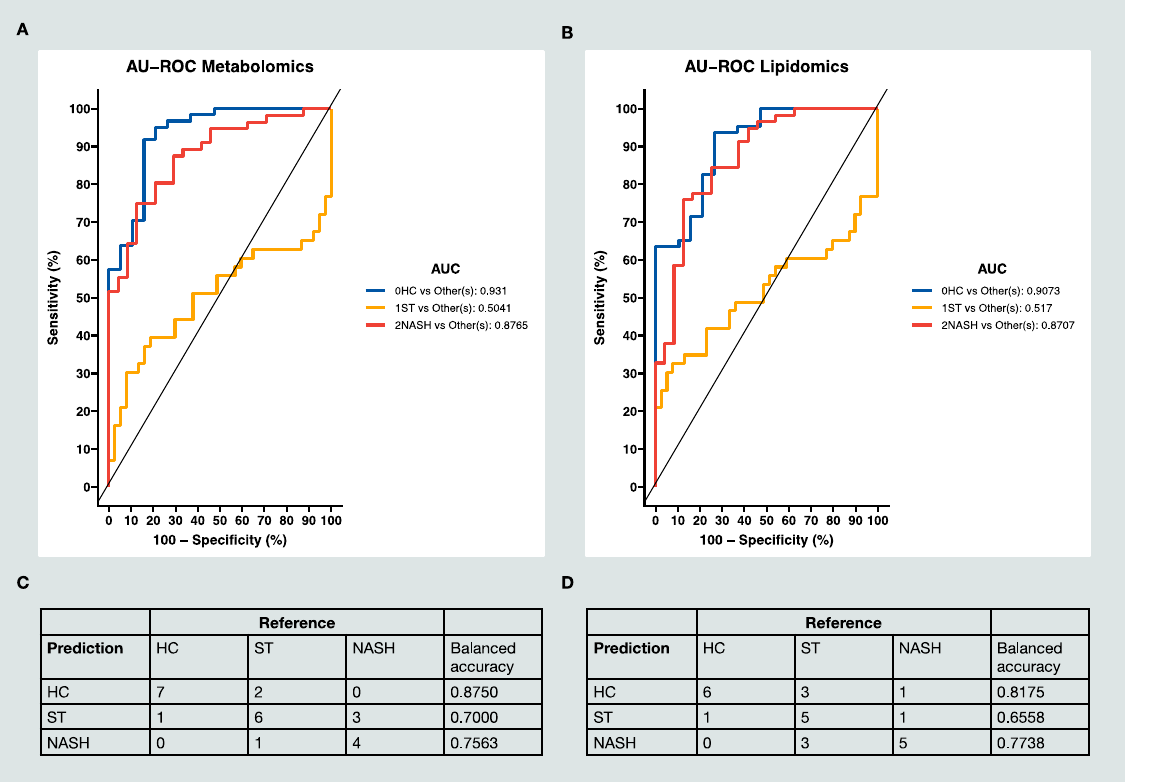
Figure 4. The classification of HC, ST and NASH patients based on MS data: ( A ) the ROC curve and AUC from the sPLS ‐ DA for the metabolomic data of the first component; ( B ) the ROC curve and AUC from the sPLS ‐ DA for the lipidomic data of the first component; ( C ) the confusion matrix of the test set sample ( n = 24) from the sPLS ‐ DA for the metabolomic data; ( D ) the confusion matrix of the test set sample ( n = 25) from the sPLS ‐ DA for the lipidomic data. Note: balanced accuracy = (sensitivity + specificity)/2.